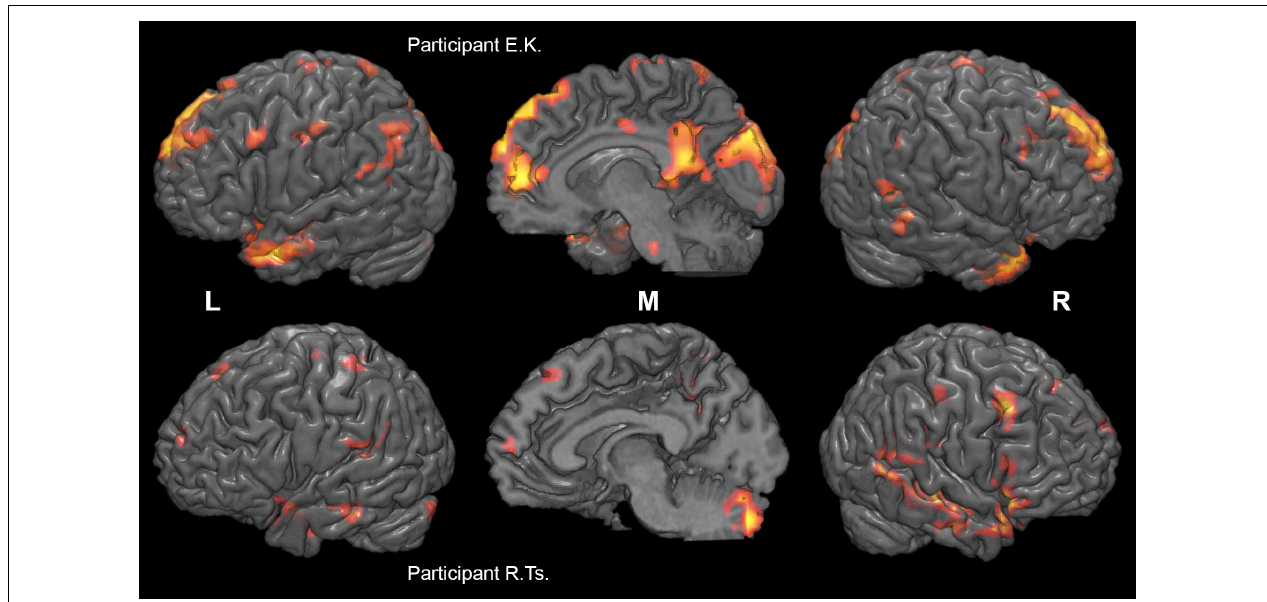
FIGURE 5 | Individual differences in neural substrates specific to collective compared to individual problem solving. Activation maps from the two sample individual participants (E. K., top, and R. Ts., bottom) are thresholded at p < 0.005 (uncorrected), k > 10, and rendered on individual anatomical images using MRICroGL (C. Rorden, http://www.mccauslandcenter.sc.edu/mricrogl/). Voxels activated by scrambled speech vs. rest at p < 0.05 (uncorrected) are masked out.